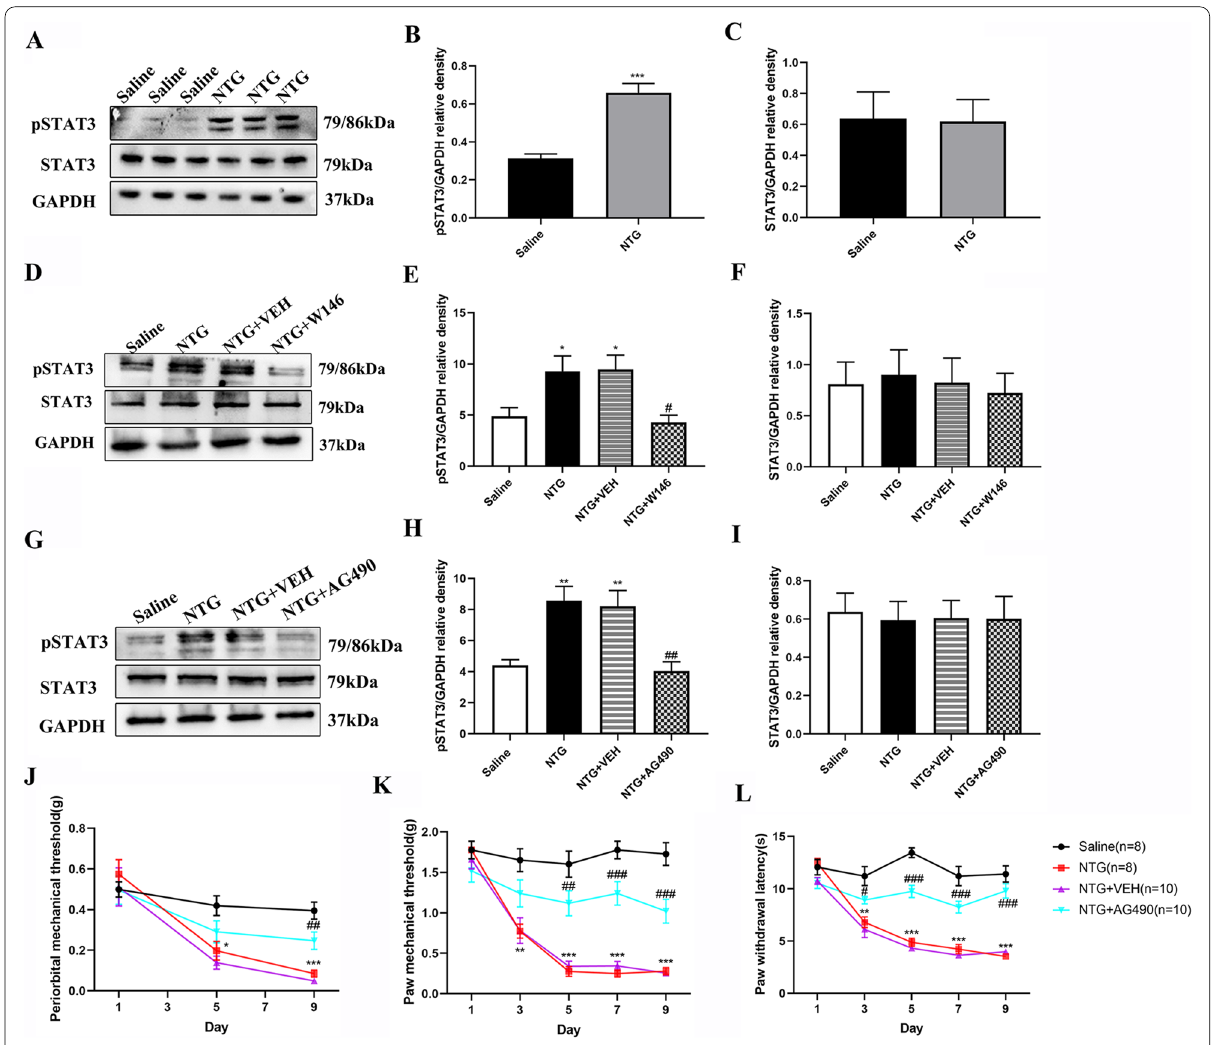
Fig. 6 Inhibition of STAT3 activity attenuated chronic NTG-induced mechanical and thermal hyperalgesia. A‑C Representative immunoblot showed that the expression level of pSTAT3 was up-regulated after repeated NTG administration (A, B) , while the expression of STAT3 remained unchanged (A, C) . The band intensities of pSTAT3/STAT3 were compared with GAPDH, respectively. n 6 per group. *** p < 0.001 compared with the Saline = group. D, F Representative immunoblot showed that the expression level of pSTAT3 decreased in the NTG W146 group, but the expression level + of STAT3 remained unchanged. n 6 per group. * p < 0.05 compared with the Saline group. # p < 0.05 compared with the NTG group. G‑I The STAT3 = signaling inhibitor AG490 reversed the increase of pSTAT3( G, H ) after repeated NTG injection but did not affect STAT3( G, I ) in the TCC area. n 6 per = group. ** p < 0.01 compared with the Saline group. ## p < 0.01 compared with the NTG group. J‑L Baseline thermal and mechanical pain threshold response of mice. Two-way ANOVA and Bonferroni post hoc test analysis; * p < 0.05, ** p < 0.01 and *** p < 0.001 compared with the Saline group; # p < 0.05, ## p < 0.01 and ### p < 0.001 for the NTG AG490 group compared with the NTG +